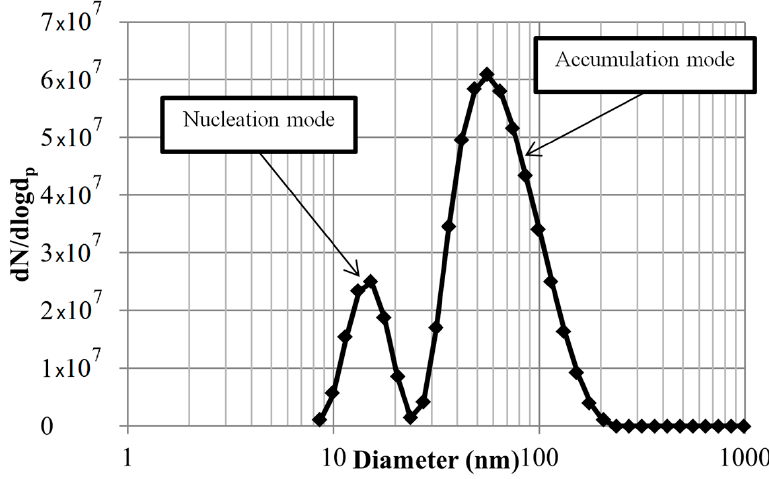
Figure 3. Typical engine exhaust particle size distributions [51].